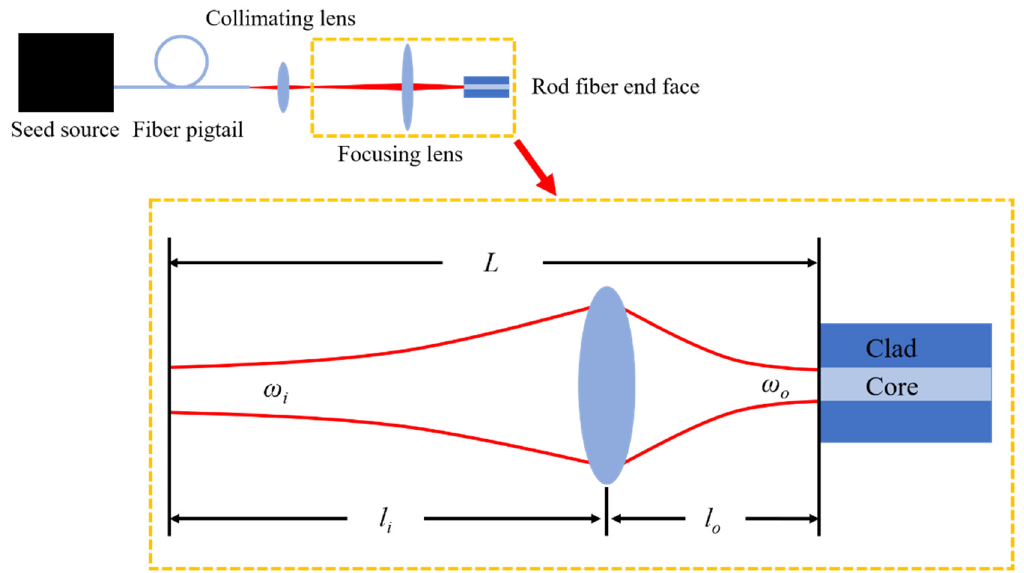
Figure 2. The scheme of the theoretical analysis.